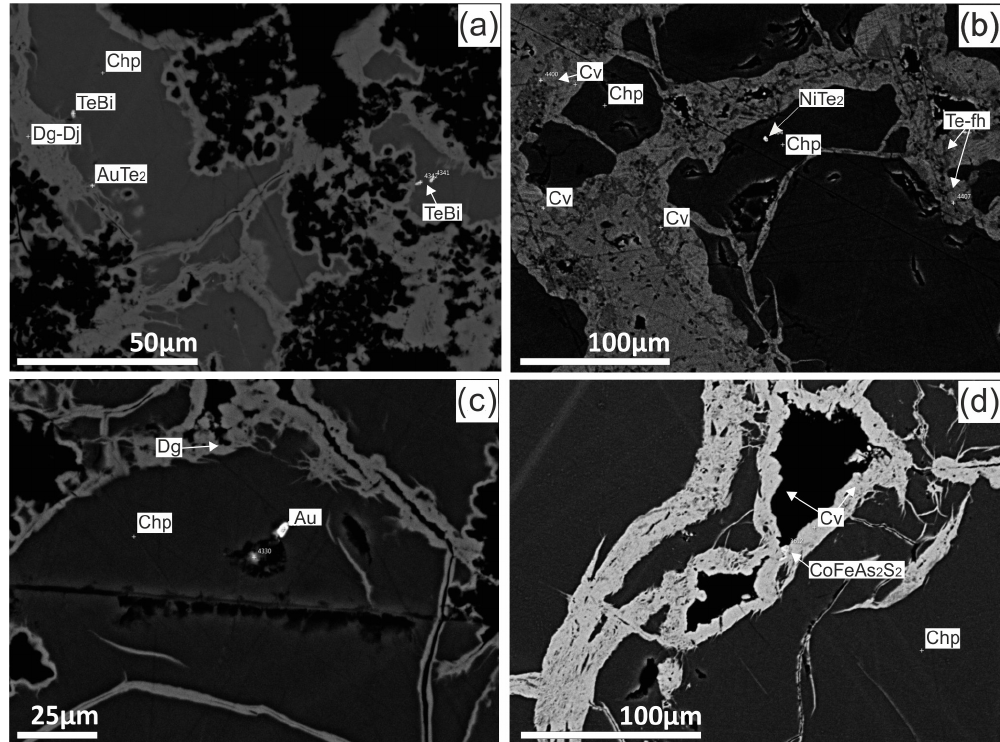
Figure 4. Au and Te minerals of chalcopyrite chimneys. BSE photographs. ( a ) Tellurobismuthite (Bi 2 Te 3 ) in the centre of granular unaltered chalcopyrite (Chp) grains. Calaverite (AuTe 2 ) on the boundary of chalcopyrite replaced by digenite-jarleite (Dg-Dj); ( b ) Melonite (NiTe 2 ) in the chalcopyrite grain. Te-rich “fahlore” (Te-fh) located in the covellite zone; ( c ) Native gold (Au) in the pores of chalcopyrite aggregate; ( d ) Sulfoarsenides in the outer covellite zone.